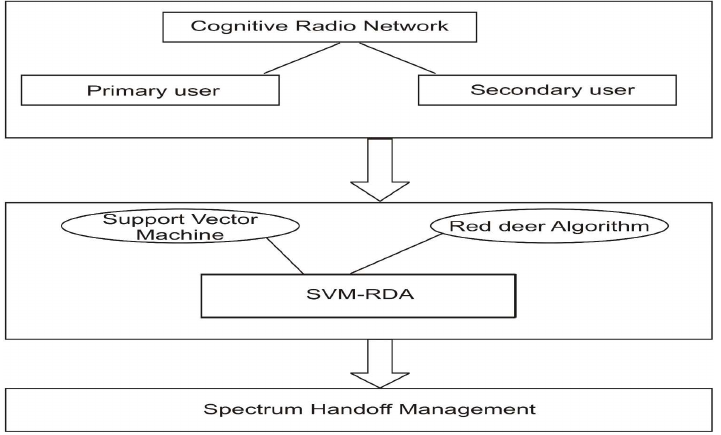
Figure 1. Proposed architecture diagram of SVM-RDA.